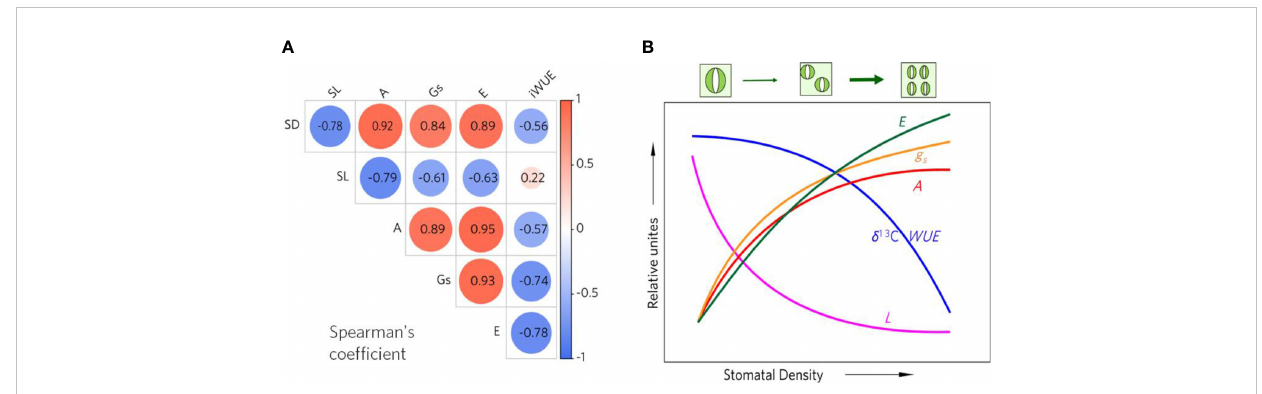
FIGURE 4 Spearman ’ s correlation coef fi cient heat map (A) , and a conceptual fi gure (B) showing the general relationships among stomatal size ( L ), water use ef fi ciency inferred from carbon isotope ratio ( d 13 C WUE ), photosynthesis ( A ), transpiration ( E ), stomatal conductance ( g s ) to stomatal density ( D ) in